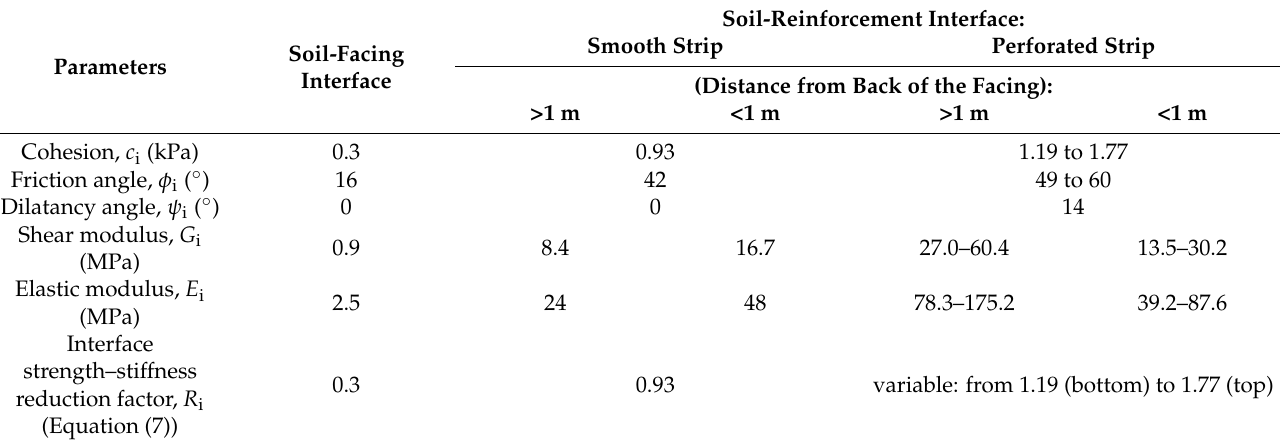
Table 3. Interface material properties.